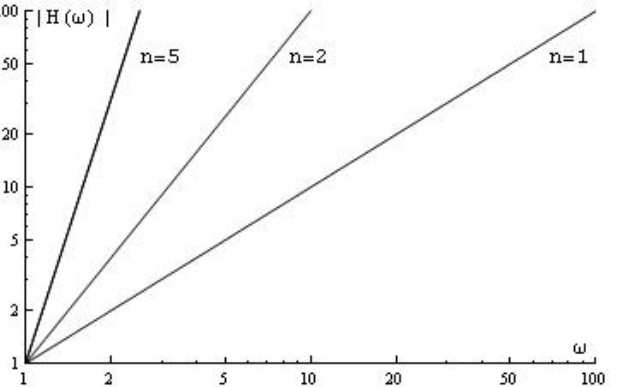
Figure 1. Moduli of the frequency response of an n -th order differentiator for n = 1 , n = 2 and n = 5